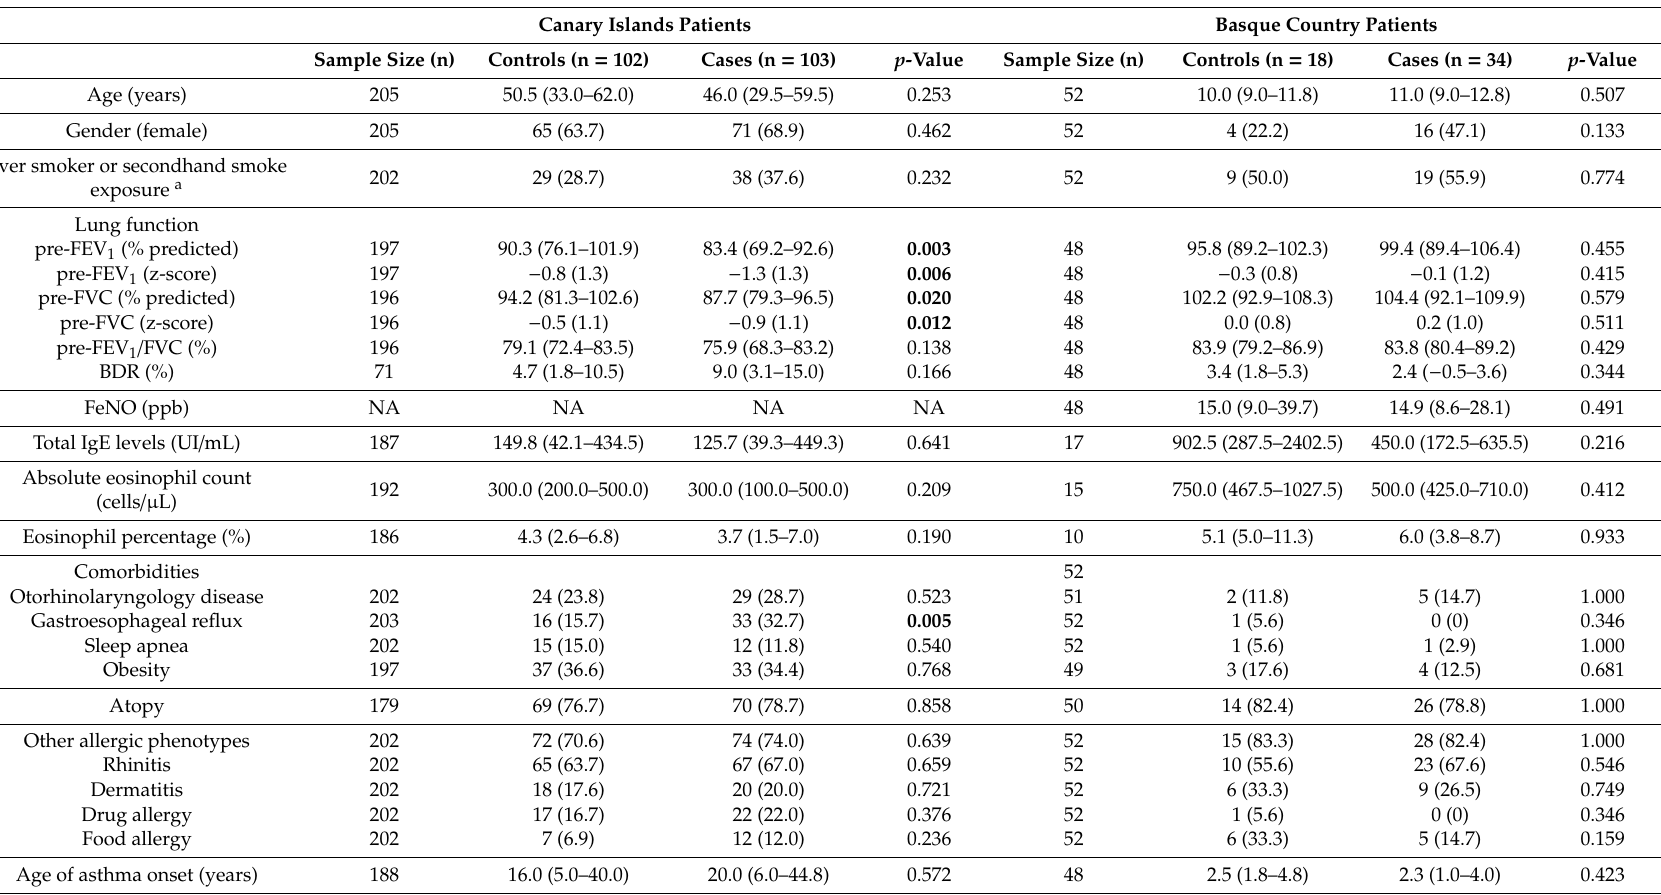
Table 1. Description of patients with asthma recruited in the GEMAS